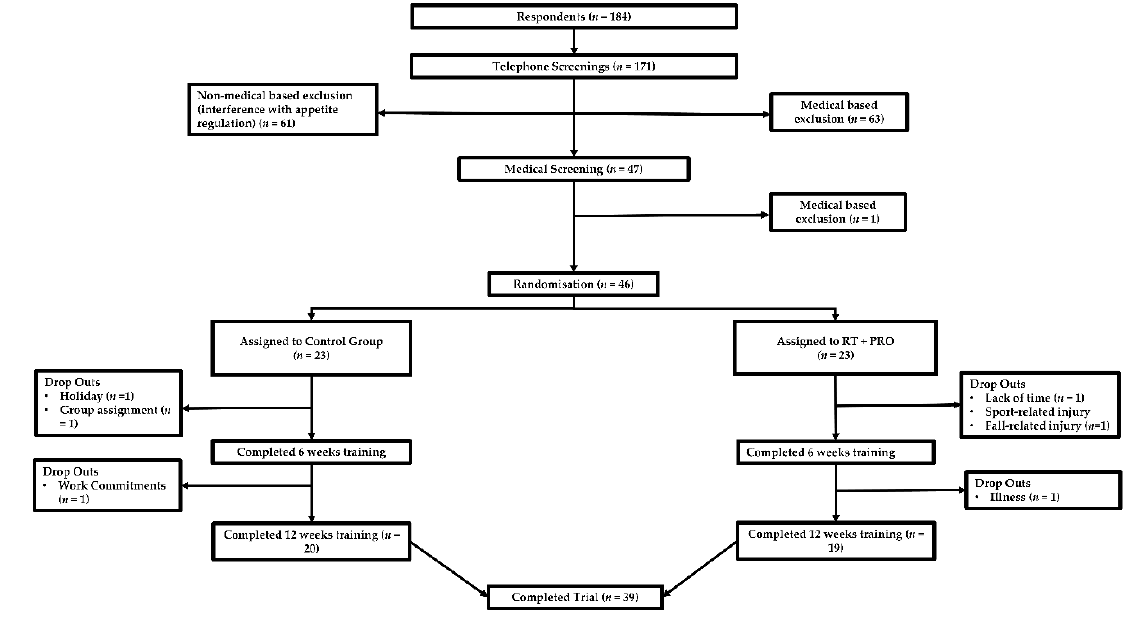
Figure 1. Participant flow from initial respondents to study completion. * Drop-outs related to training and/or testing. Injury and illness were not as a result of the intervention. Table 1. Participant Characteristics (Mean ±